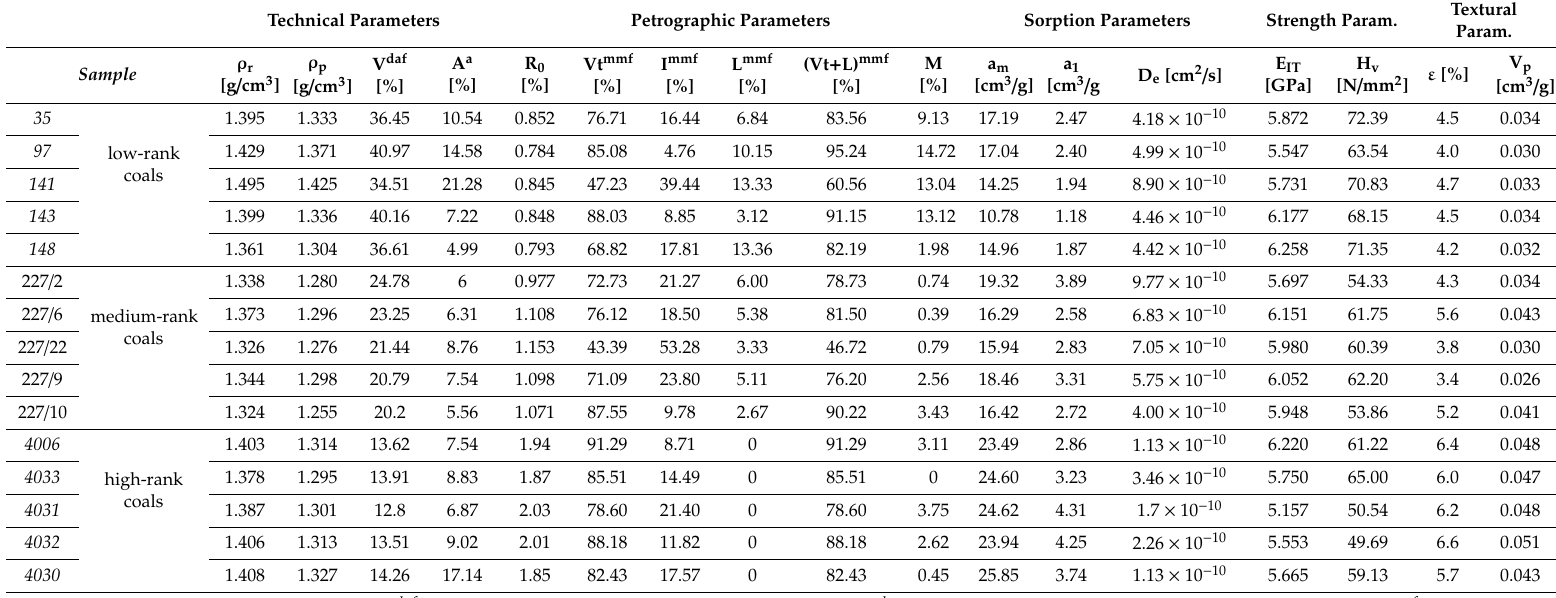
Table 1. Results of technical, petrographic, sorption, strength, and texture tests of the studied coal samples. Technical Parameters Petrographic Parameters Sorption Parameters Strength Param.